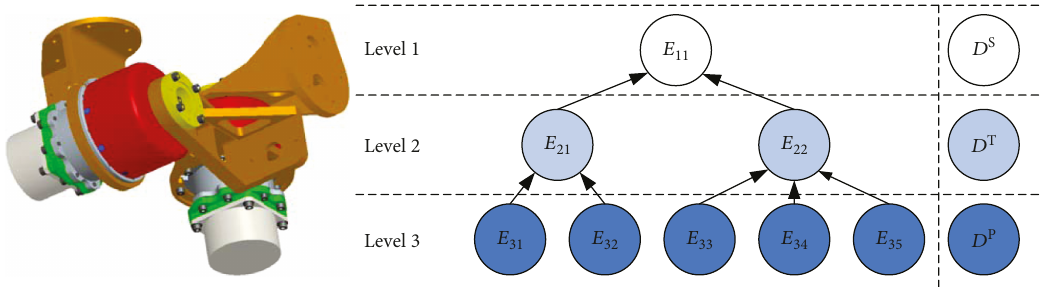
Figure 7: The HGD device employed for the case study and its corresponding system structure. Table 2: Predetermined bottom element probabilities. Basic component elements